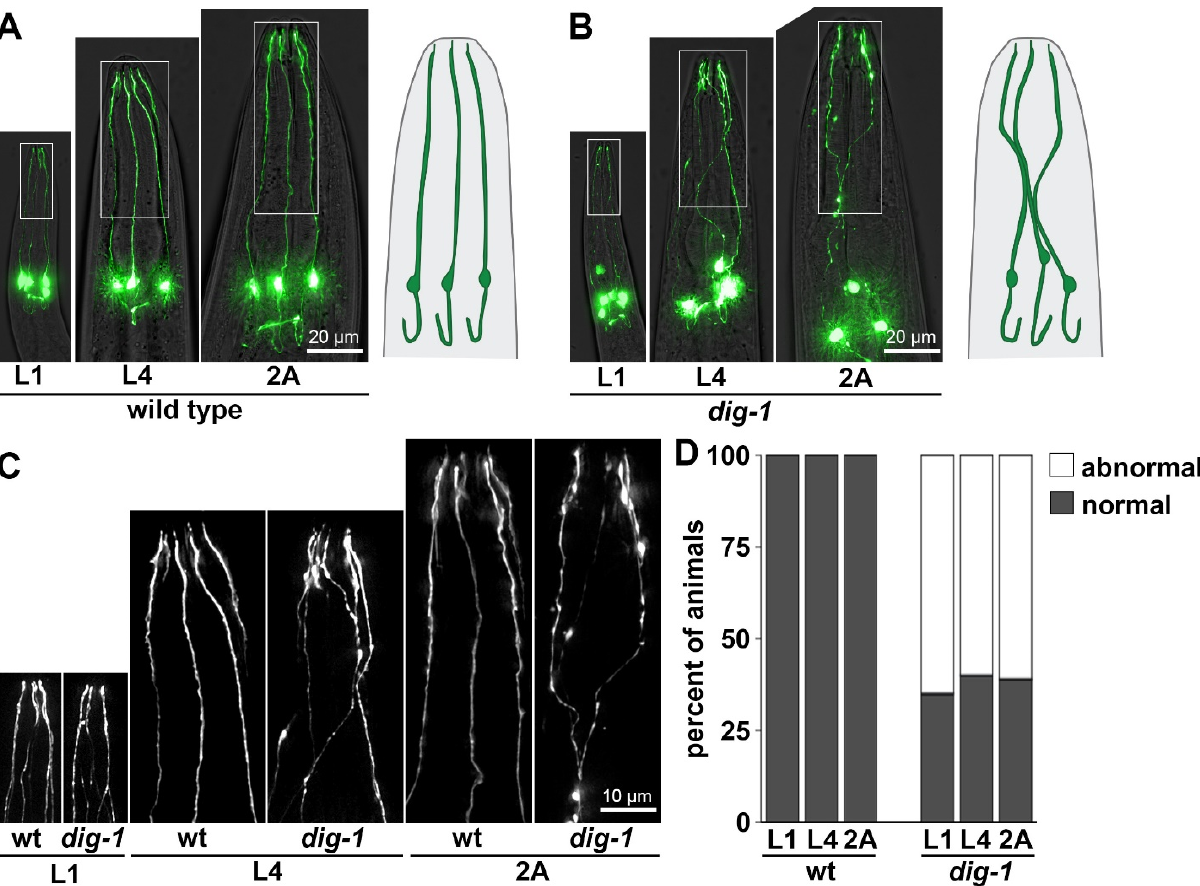
Figure 4. IL2 dendrites exhibit fasciculation defects in dig-1 mutants. Heads of ( A ) wild-type and ( B ) dig-1 ( n1321 ) animals at the L1, L4, and 2A stages, showing fasciculation defects at all stages in dig-1 animals. Animals express klp-6 pro:GFP. Schematics of IL2 neurons are shown on the right. ( C ) 2× magnification of boxed regions in A and B. ( D ) Quantification of phenotype penetrance at each stage. n = 20 animals per genotype at each stage.